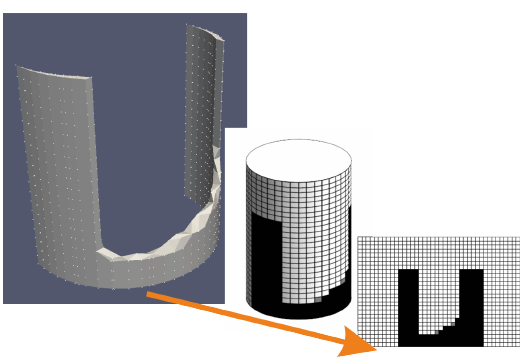
Figure 4. Main steps in generating the CWE - from left to right: intersection tridexel, CWE calculation, CWE matrix.